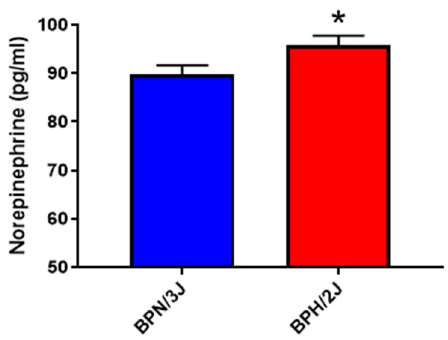
Figure 2. Norepinephrine levels are significantly increased in the kidneys of BPH/2J neurogenically hypertensive mice compared to BPN/3J normotensive mice. Quantitation of NE levels in kidneys using a specific mouse NE ELISA. * p = 0.04; data represented as mean ± SEM; n = 13–14/group.